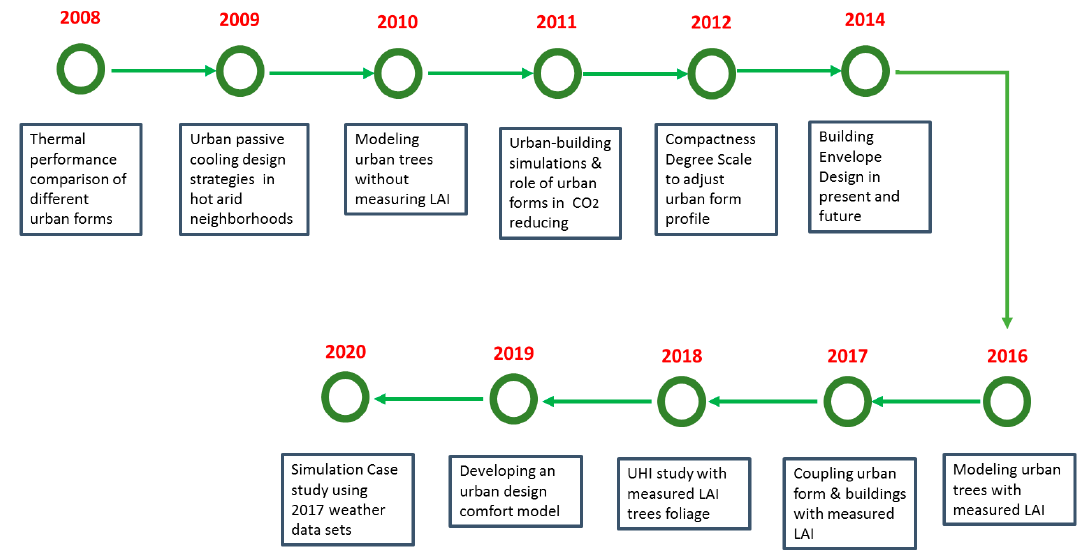
Figure 1. A brief for the design complexities and milestones that have been solved by the research line reviewed in this article, (2008–2020).